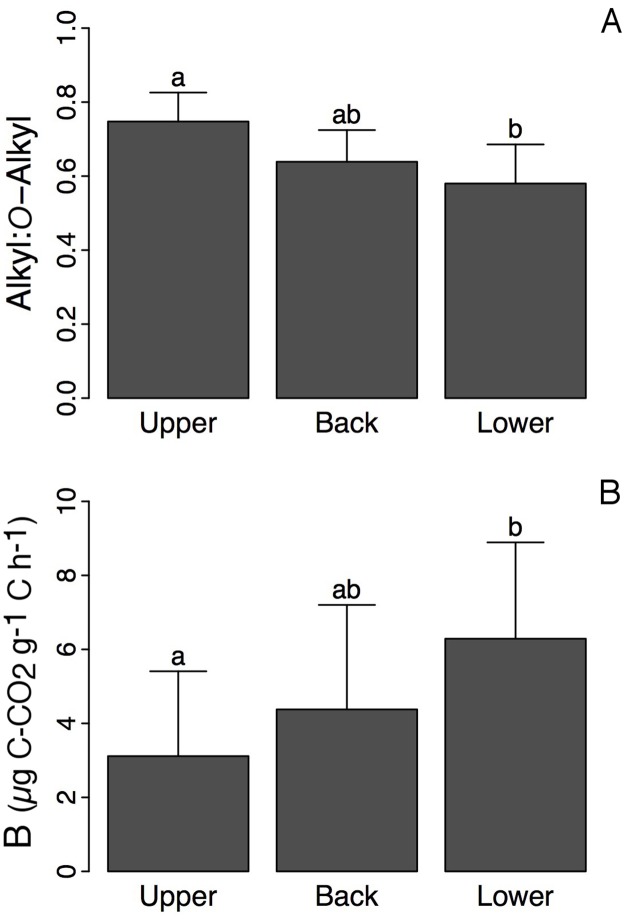
Effect of the slope position on forest floor organic C quality.(A) Forest floor alkyl:O-alkyl C ratio (mean ± SD; n = 24) and (B) B parameter (mean ± SD; n = 24) in the upper, back, and lower slope positions. Values not sharing the same letters are significantly different (ANOVA followed by Tukey’s HSD test; P < 0.05).